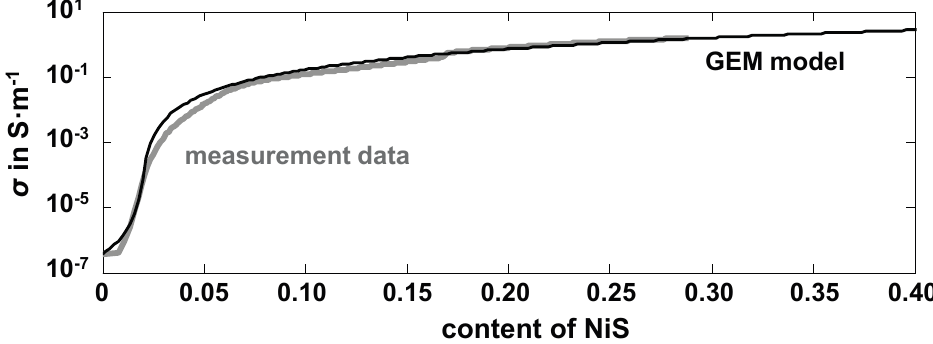
Figure 5. Measured effective conductivity and the calculated values from the GEMT model, plotted over the content of the converted nickel to nickel sulfide; Experimental data: T = 300 °C, 500 ppm H 2 S in N 2 , V = 50 L · h − 1 (NTP), p = 1